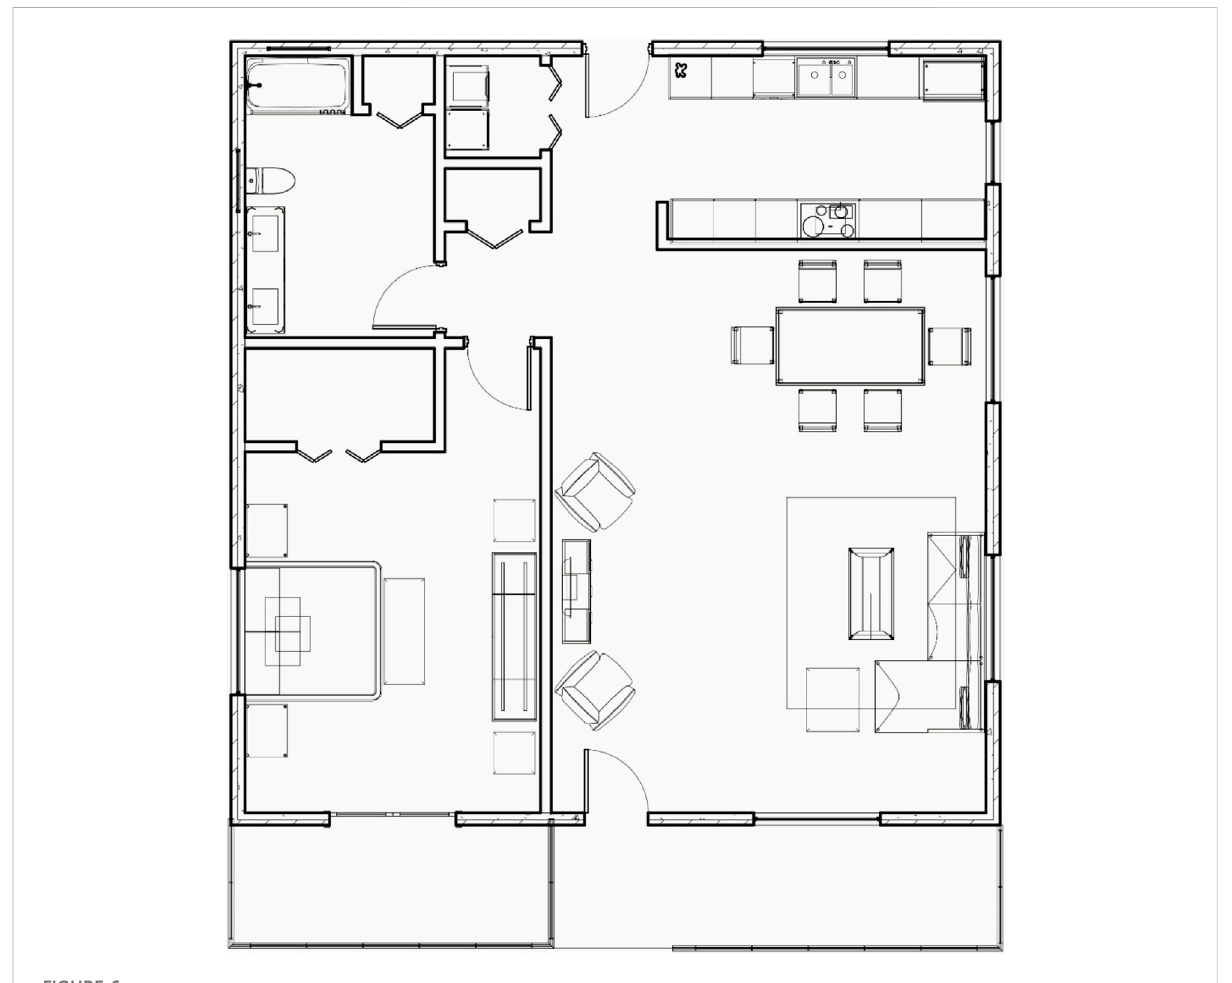
FIGURE 6 The fl oor plan example used in the